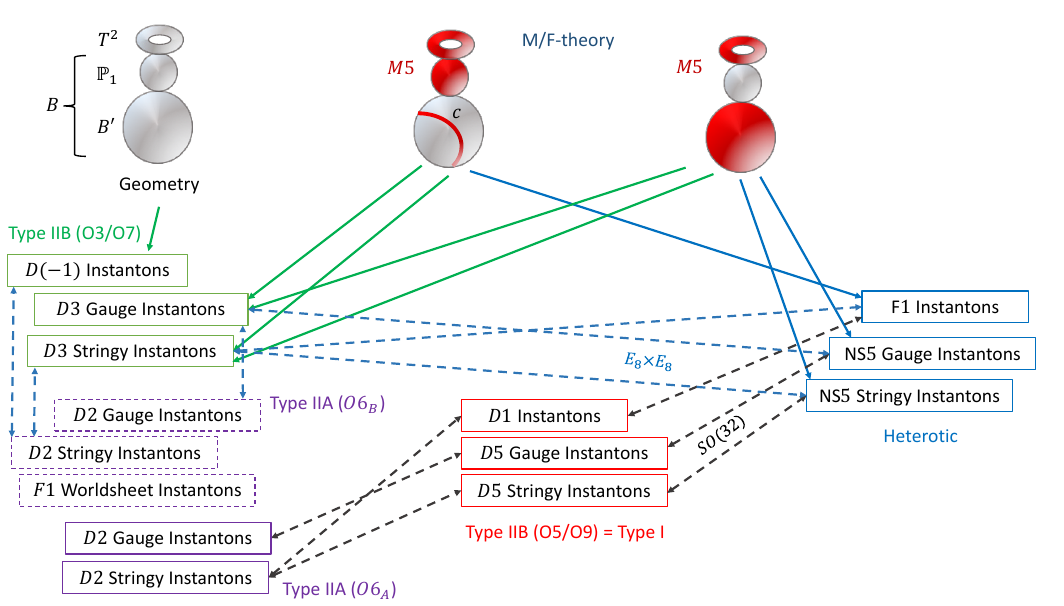
Figure 1 . Various types of instantons that appear in string theory, and their relations through dualities given by dashed lines. The dualities can be understood through their M-theory origin, which can also be used to calculate the (neutral) zero-modes of the